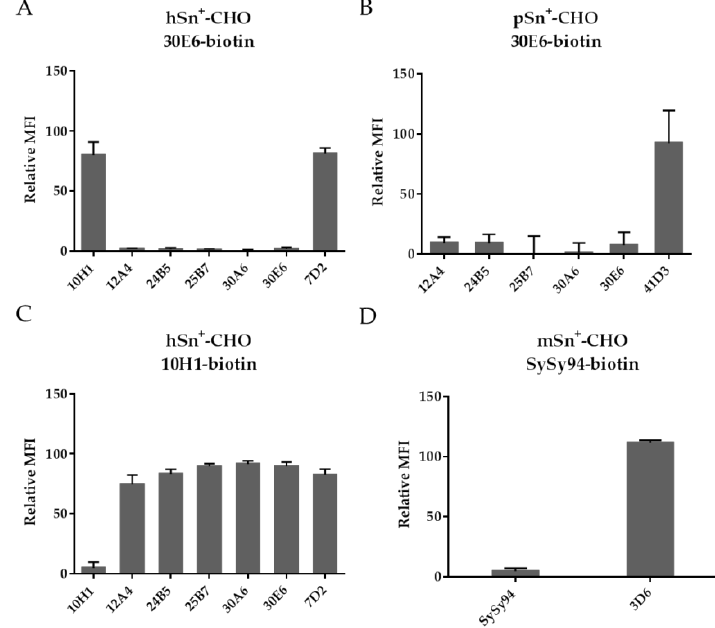
Figure 4. Competitive binding assay to cluster mAb binding using flow cytometry. An excess of mAbs was added to Sn + -cells. After 60 min of incubation, biotinylated-mAbs were added and unbound mAbs were removed after 60 min. Fluorescently-labeled streptavidin was added to stain only the bound biotinylated-mAbs. Dead cells were excluded using PI. A high fluorescent signal indicated the mAb had a different epitope than the biotinylated-mAb. MAb 30E6 was biotinylated and added to ( A ) hSn + -CHO and ( B ) pSn + -CHO. Biotinylated mAbs 10H1 and SySy94 were added to ( C ) hSn + -CHO and ( D ) mSn + -CHO, respectively. The relative MFI was determined comparing the fluorescent signal of the cells to that of cells with no competition taking autofluorescence of the cells into account. The relative MFI and standard error of the mean was determined for three independent repeats.